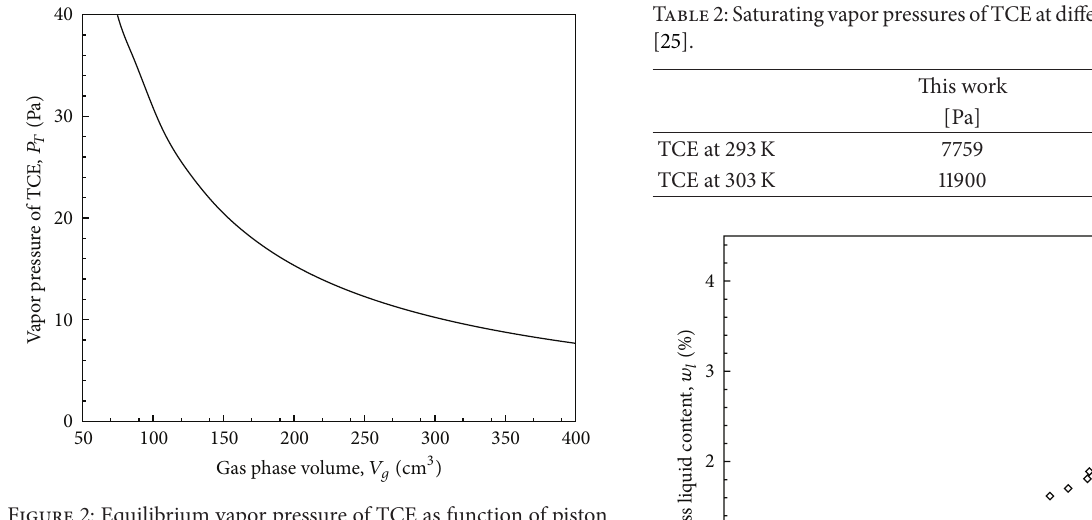
Figure 2: Equilibrium vapor pressure of TCE as function of piston volume.